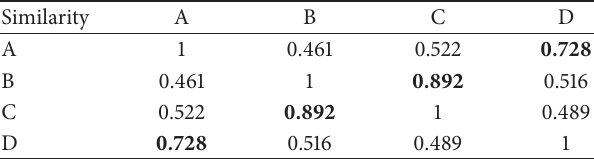
Table 4: Users’ similarity based on TFN.